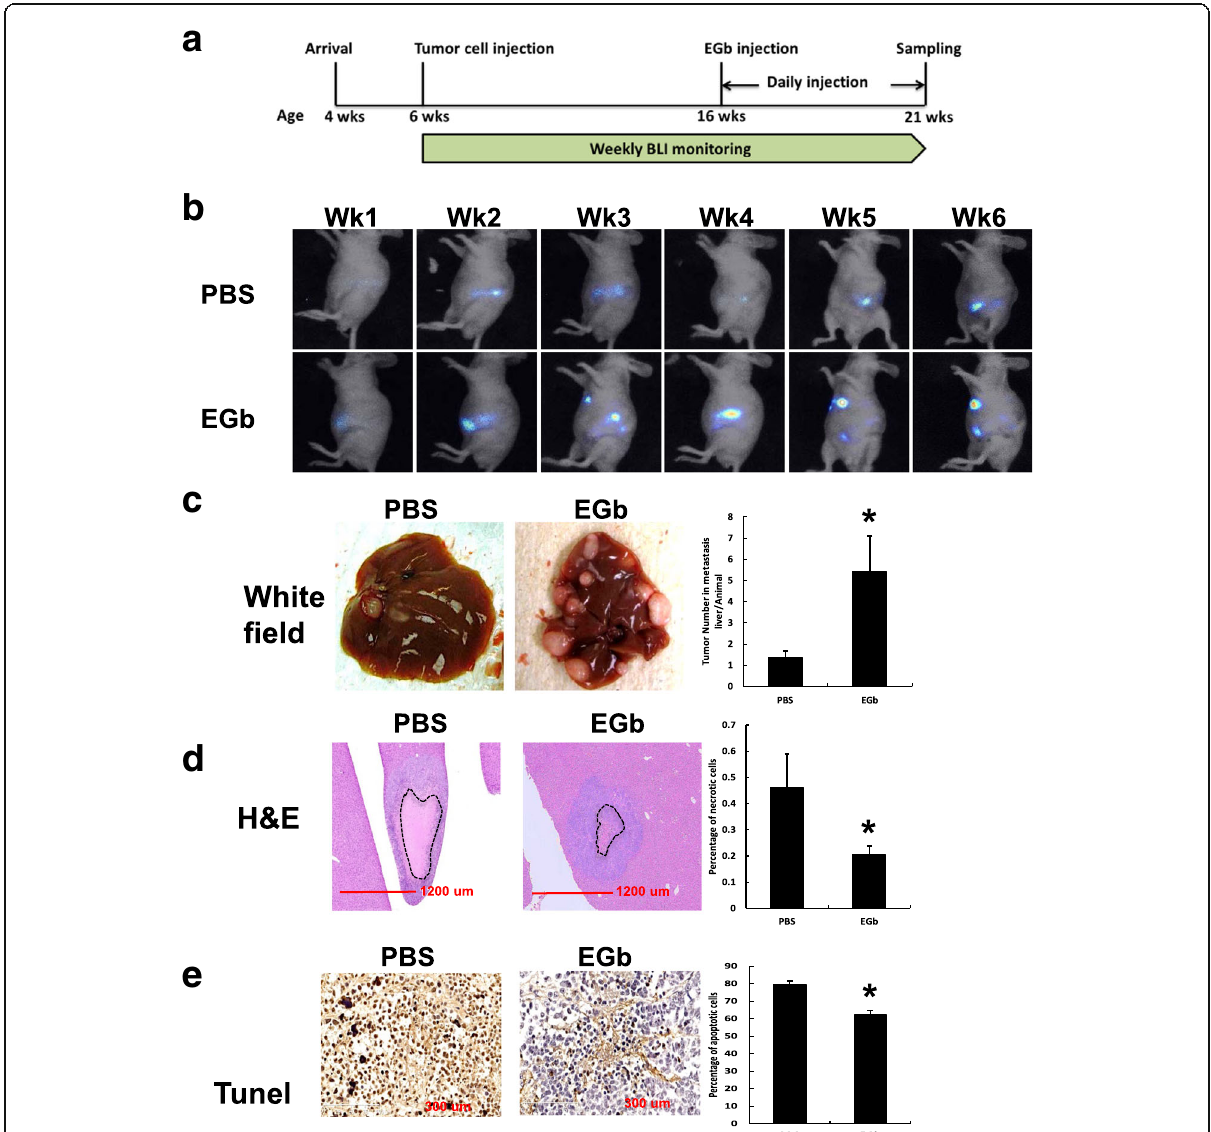
Fig. 1 Characterization of EGb treated mice underwent intrasplenic injection of colon cancer cells. a Timeline of animal trial and design. Mice were received at 4 wks of age. Food intake and body weight measurement were performed weekly from 4-wk. to 21-wk. of age. At 6 wks of age, mice were injected with SW620-luc cells. Daily injection of EGb (PBS was used as the negative control) was conducted from 16 wks of age to 21 wks of age. Mice were sacrificed after 5 wks of EGb injection. b Bioluminescence Imaging (BLI). Mice were imaged weekly from wk. 1 to wk. 6 of intraperitoneal injection of PBS or EGb. Representative imaging was shown for mice with positive bioluminescent signals. c Characterization of mouse liver containing metastatic tumors in PBS and EGb mice. Representative pictures with liver tumors are in the left panel. Quantification of numbers of tumors in liver after EGb treatment is shown in the right panel. Y-axis represents the number of tumors in the metastatic liver per animal. d Necropsy and pathology by structural staining using H&E of mouse liver. Representative images with metastatic tumor in the liver were shown for PBS and EGb groups (5× magnification). Gross structure was stained in pink and nuclei were stained in purple. Dotted lines were used to circle the necrotic area in the tumors that were quantified. Right panel shows the quantification of necrotic area (%) in PBS and EGb treated mouse liver. Y-axis indicates the percentage of necrotic area within the tumor. e TUNEL analysis of apoptosis in liver tumors. Representative pictures are shown. Brown dots are the positively stained nuclei of apoptotic cells. Quantification of apoptotic cells in PBS and EGb treated livers are in the right panel. Y-axis indicates the percentage of apoptotic cells in the liver tumor. Asterisks (*) indicate statistical significance ( n >4 animals, p <0.05) when compared to the PBS